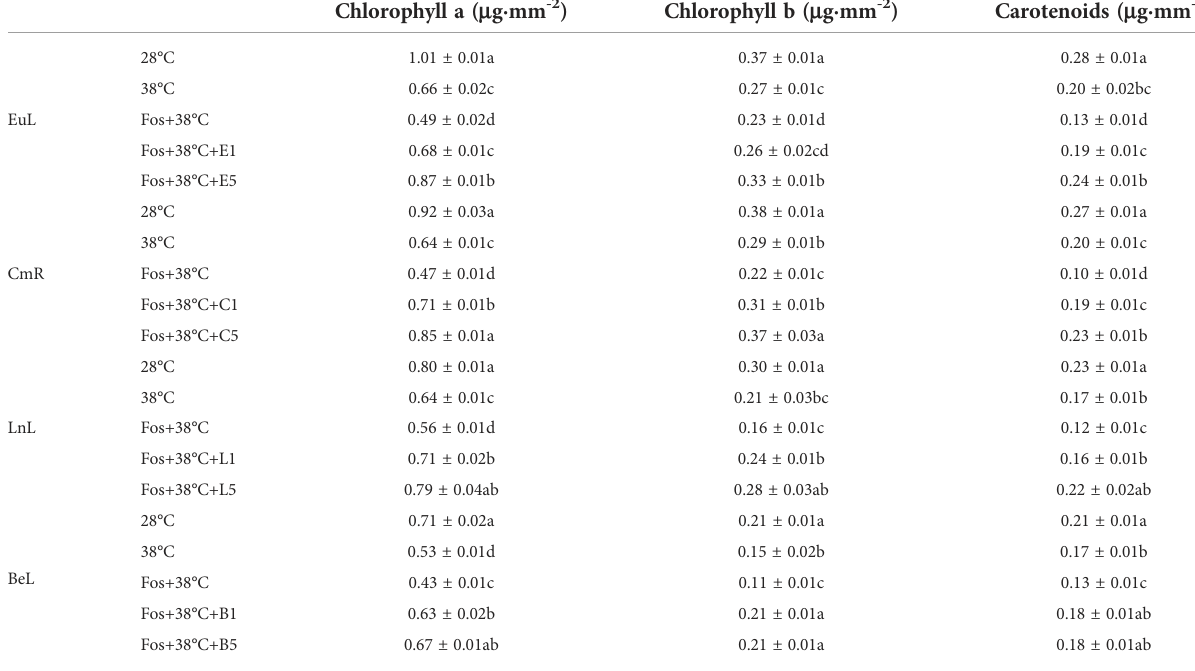
TABLE 1 Effects of the uppermost monoterpenes on photosynthetic pigment content in C.